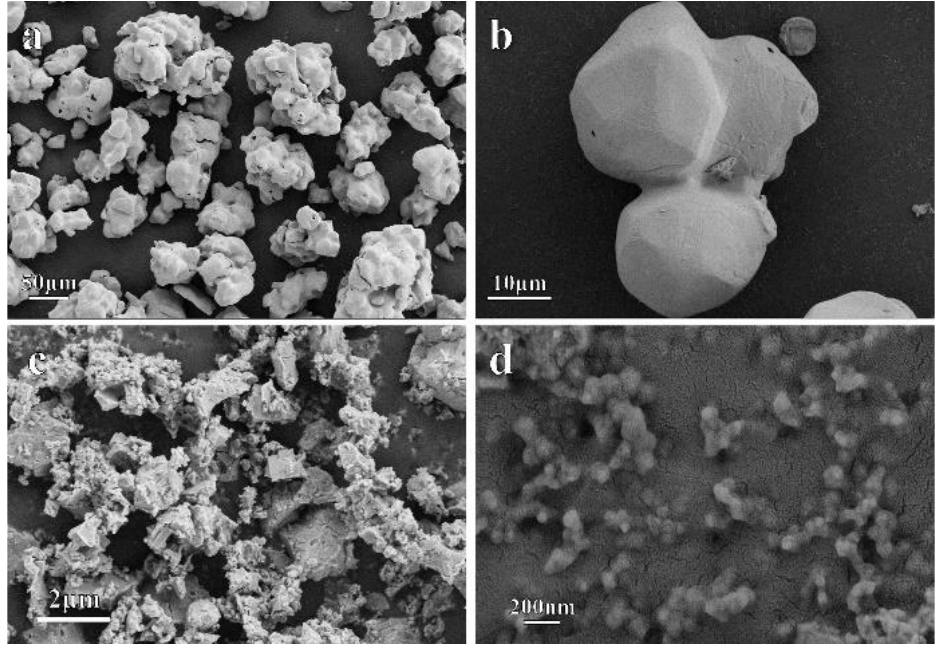
Figure 4. The typical morphological images of the Mn 3 O 4 samples before ( a , b ) and after high-pres- sure torsion with 3 rotations ( c , d ). torsion with 3 rotations ( c , d